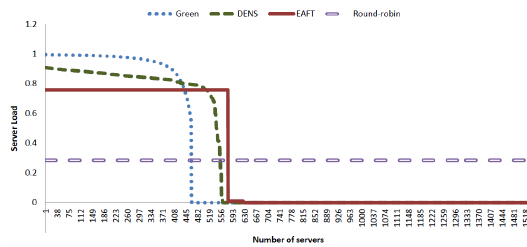
Figure 3. Data Center Workload Distribution.